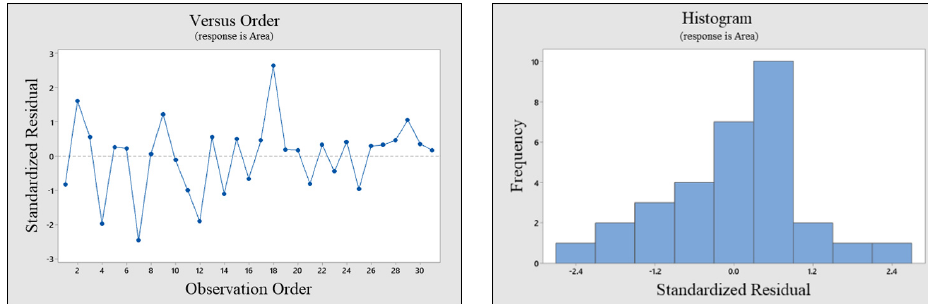
Figure 9. Standardized residual and histogram graph.